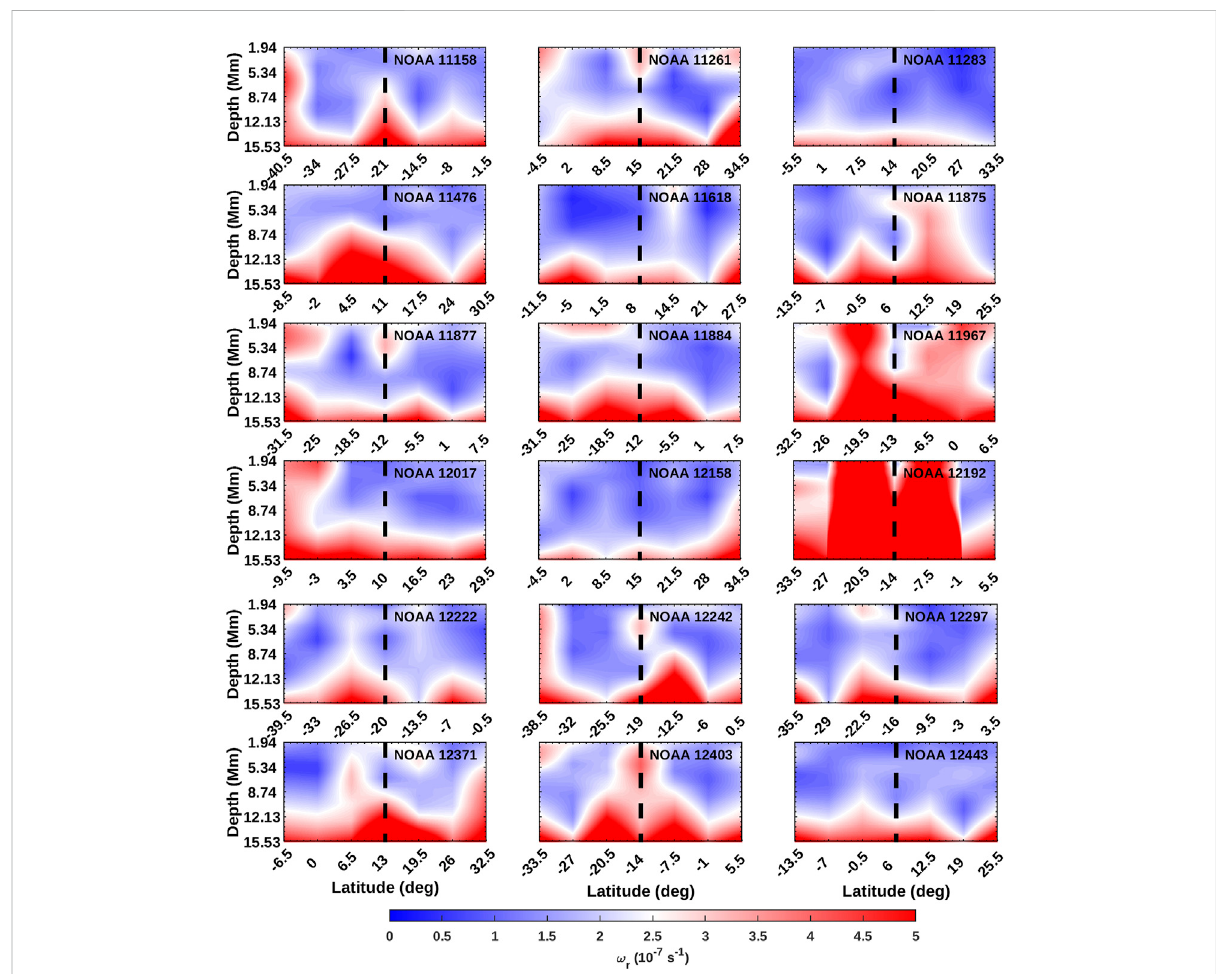
FIGURE 2 Temporal mean of absolute vertical vorticity, ω r corresponding to the 18 fl aring active regions and neighboring patches at the active region longitude, φ ar as a function of latitude and depth. The latitude of active region is represented by dashed solid